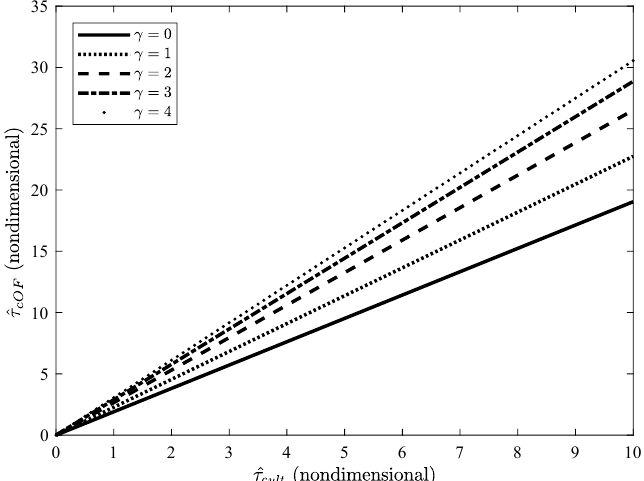
Figure 2. Behavior of ˆ τ cOF for different values of ˆ τ cult , using different values of γ . The range of ˆ τ cult was selected arbitrarily for illustration